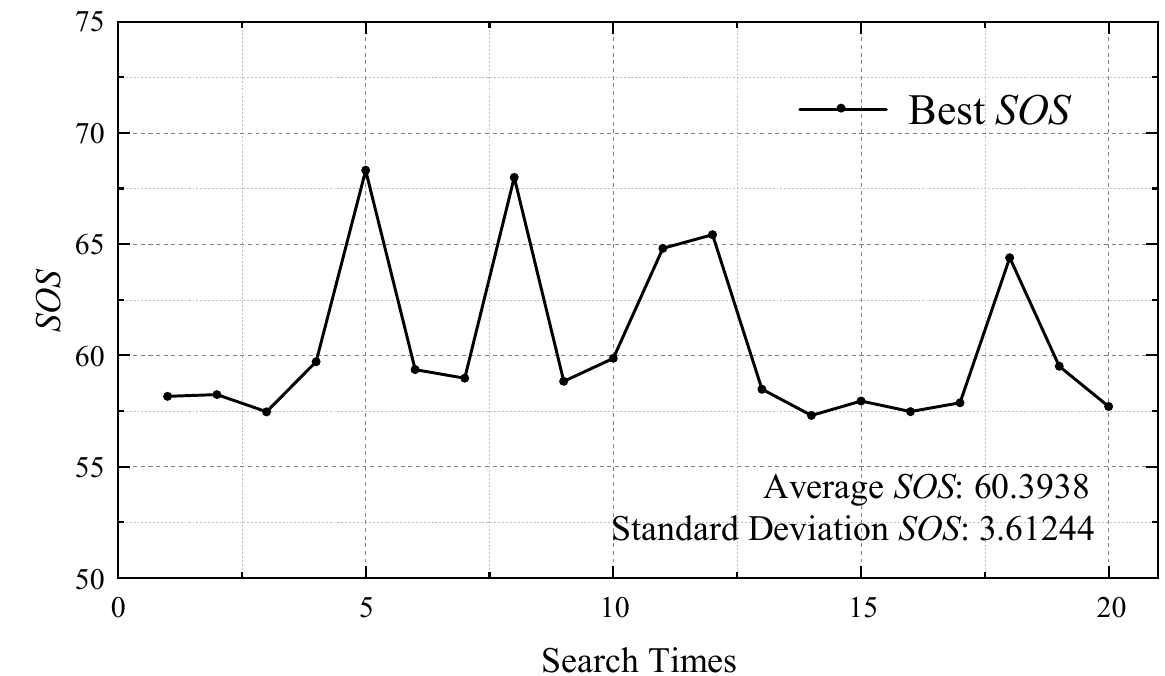
Figure 8. The best SOS calculated 20 times by IRMO: Series 4 in Table 2.